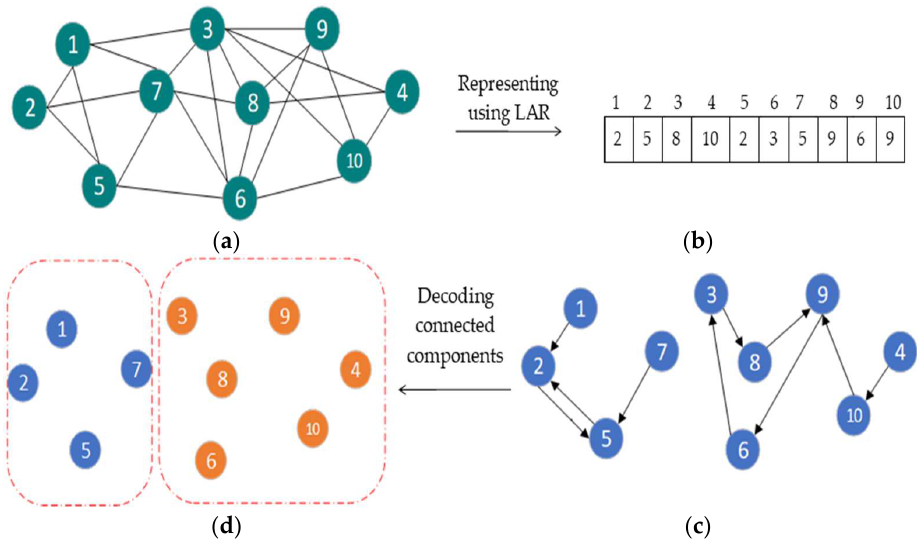
Figure 4. The methodology of community detection: ( a ) original network; ( b ) solution vector M i ; ( c ) connected components constructed by M i ; ( d ) detected communities.